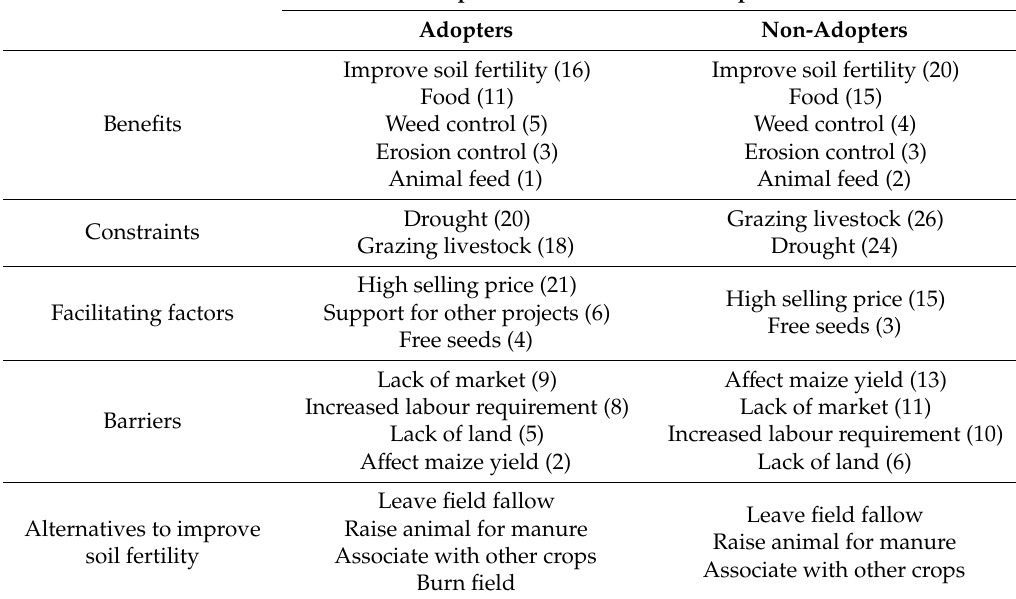
Table 7. The benefits of and constraints to ricebean production, the facilitating factors and barriers to ricebean adoption and the alternatives to improve soil fertility given by farmers during focus group discussions. The numbers next to each response for benefits, constraints, facilitating factors and barriers represent the sum of ranking values. The responses were listed from the highest to the lowest sum of ranking